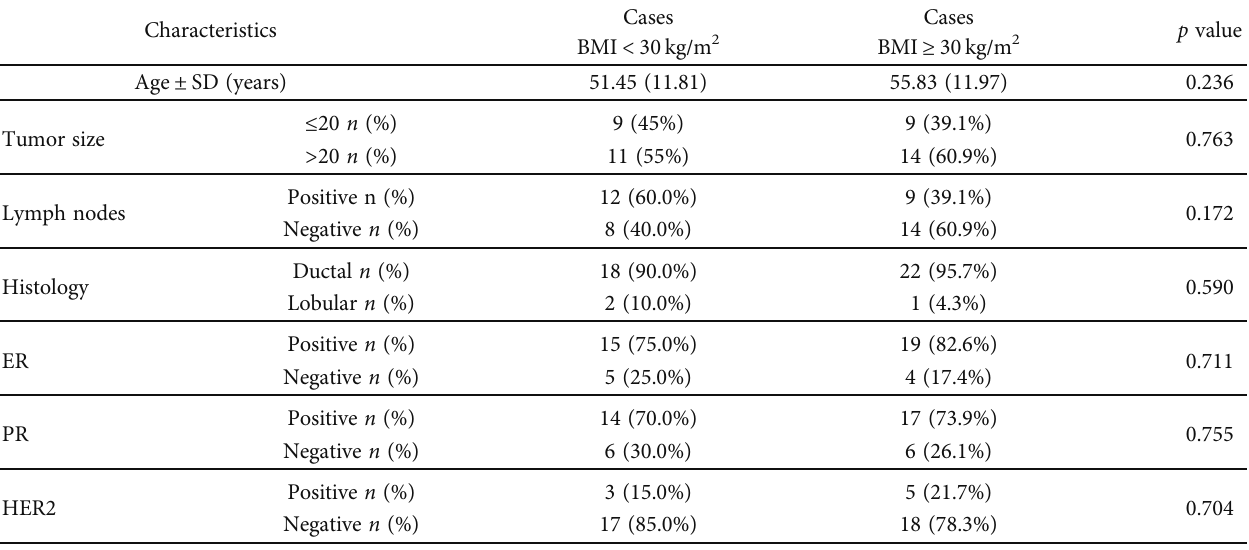
Table 1: Patient characteristics.